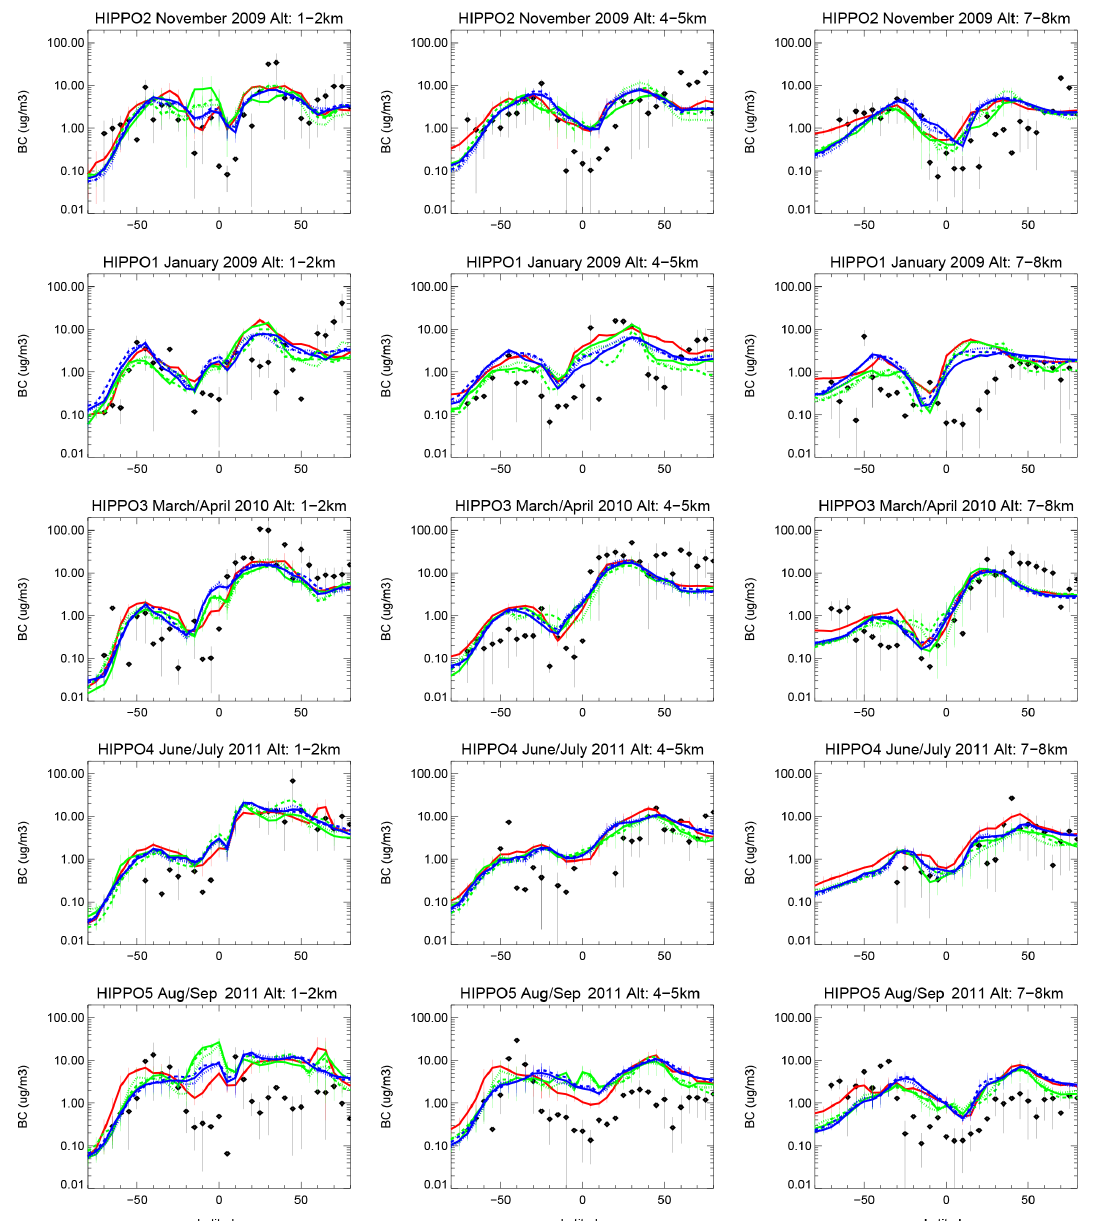
Figure 11. Black carbon comparison between different HIPPO aircraft campaigns taken over the Pacific Ocean (black symbols) and results from the reference simulations REFC1SD (red), REFC1 (green), REFC2 (blue), averaged over different altitude intervals. The sampled aircraft profiles during different HIPPO campaigns were averaged over 5 ◦ latitude intervals along the flight path over the Pacific Ocean and compared to model output averaged over the same grid points, as done in Tilmes et al. (2015). The average profiles are averaged over three altitudes regions, 1–2, 4–5 and